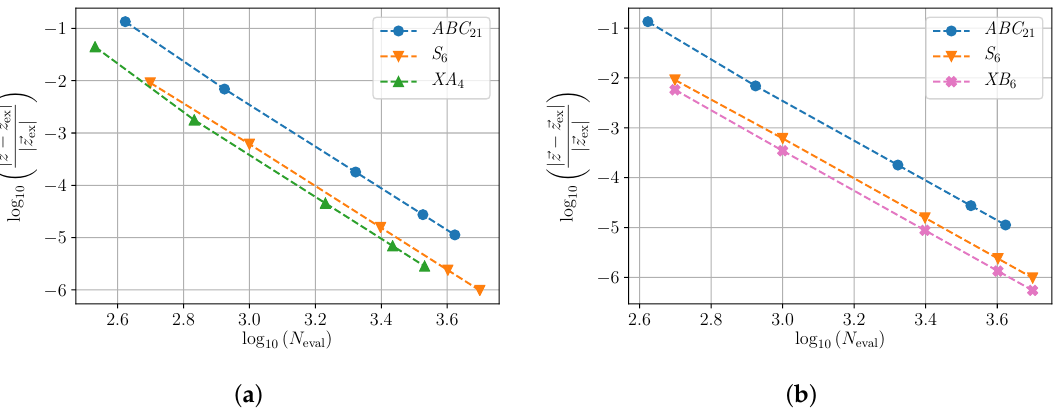
Figure 4. Relative error of trajectories for the DDNLS system. Same as in Figure 3. ( a ) Relative error of trajectories for XA 4 compared to ABC 21 and S 6 . ( b ) Relative error of trajectories for XB 6 compared to ABC 21 and S 6